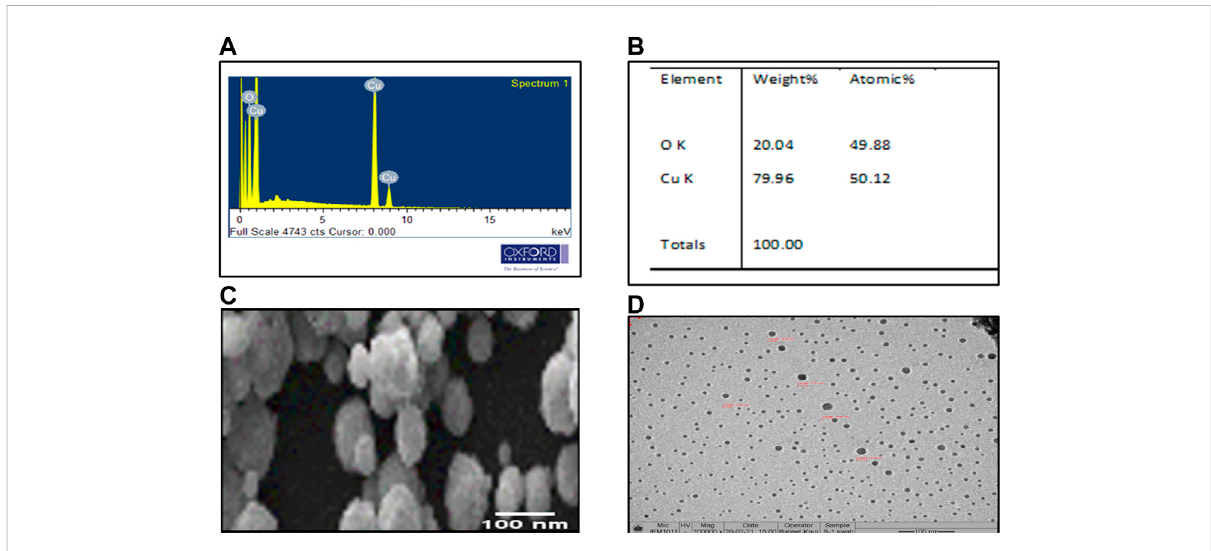
FIGURE 5 Microscopic analysis of M-CuO NPs: (A,B) EDX analysis of M - CuO NPs, (C) SEM image of M - CuO NPs, and (D) HR - TEM image of M - CuO